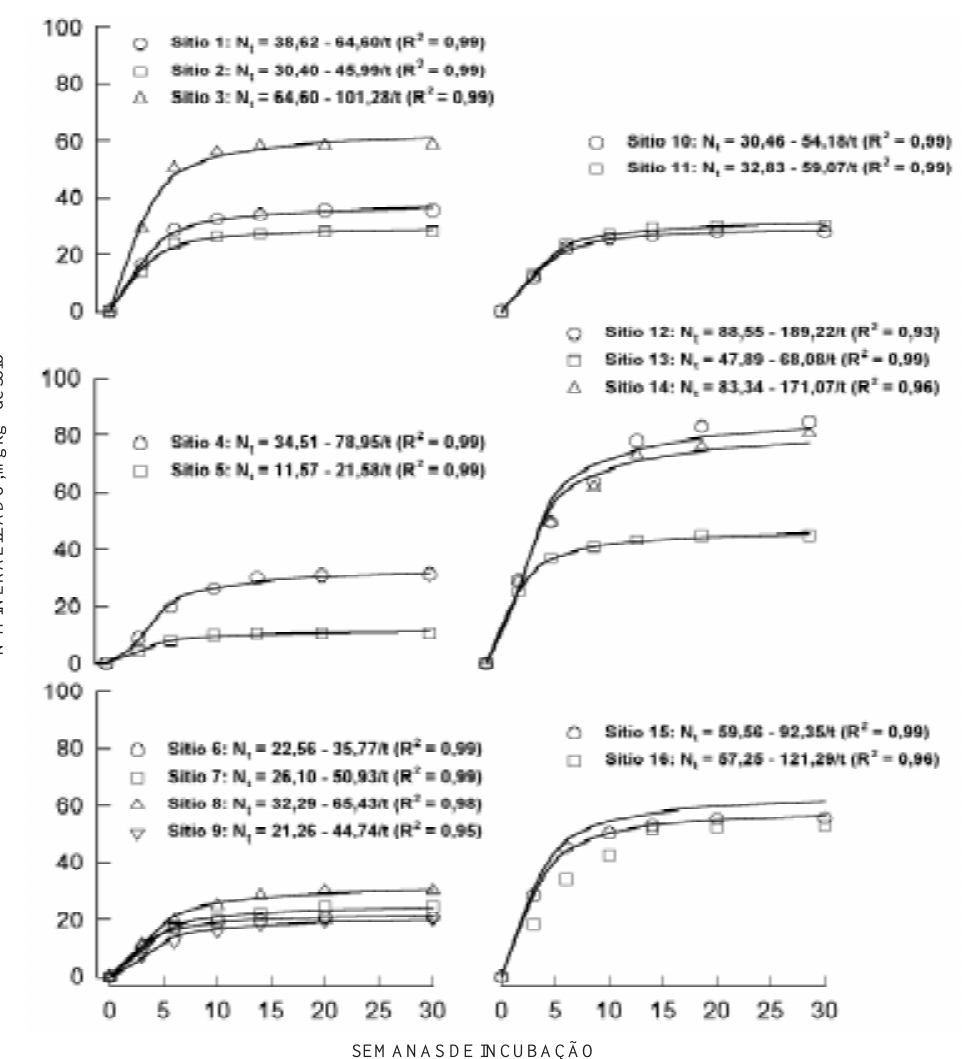
Figura 1. Curvas de mineralização aeróbia de N para a camada de 0-15 cm dos solos amostrados nos diversos sítios florestais. Todos os valores dos coeficientes de determinação são significativos a 1%.